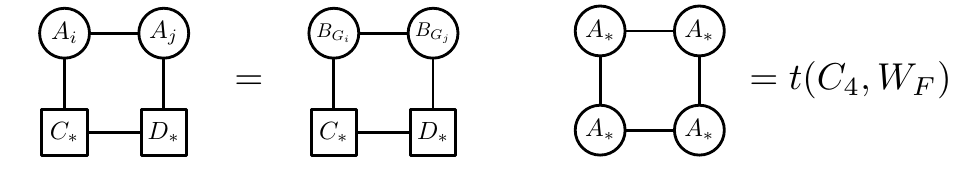
Figure 19: The decorated constraints forcing the structure of the tile A ∗ × A ∗ . The first constraint should hold for all i ∈ [ M ] and j ∈ [ M ]